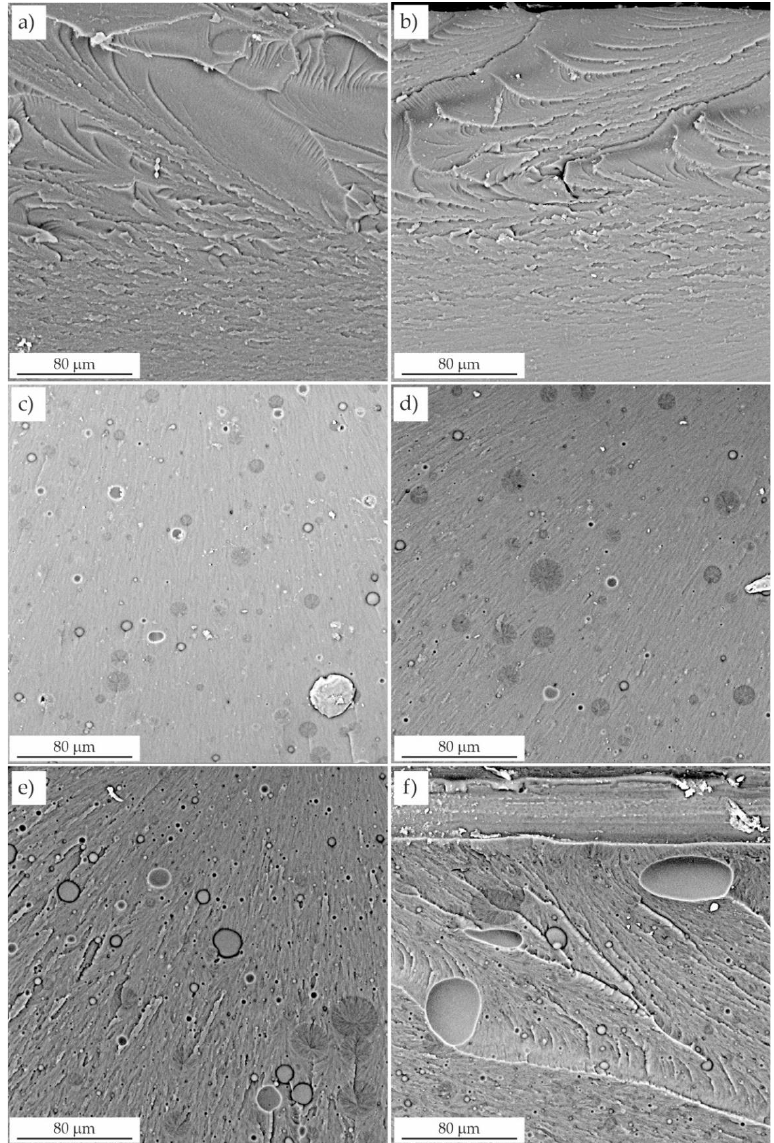
Figure 8. Fractures of unmodified and modified resins. ( a ) resin F, ( b ) resin C, ( c ) resin C + 5 wt.% LR, ( d ) resin C + 5 wt.% LR, ( e ) resin F + 10 wt.% LR, ( f ) resin C + 10 wt.% LR.